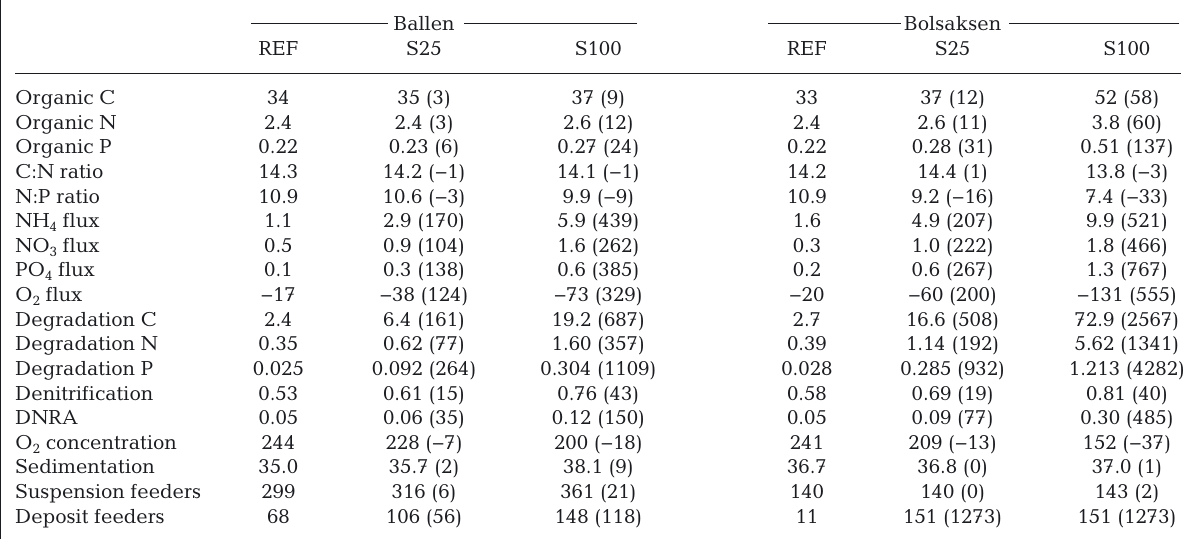
Table 5. Average sediment organic content (mol m −2 ) of C, N, and P; nutrient fluxes (mmol m −2 d −1 ) and oxygen